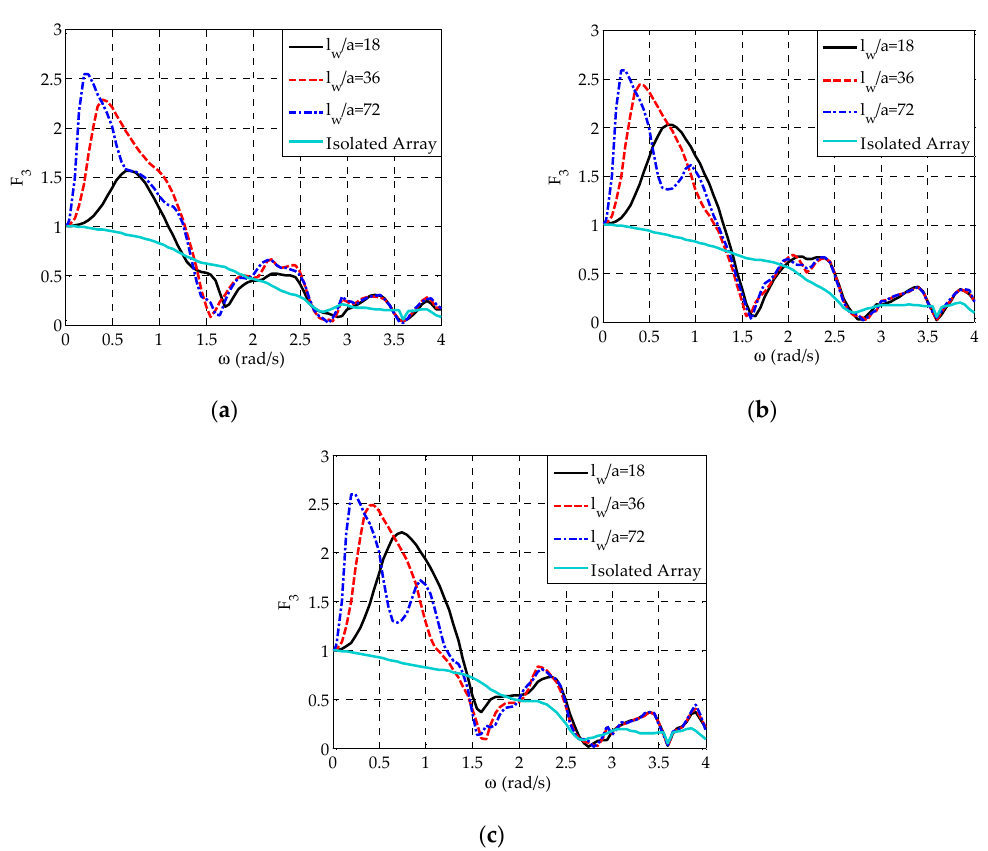
Figure 10. E ff ect of l w / a on F 3 applied on the semi-immersed oblate spheroidal WECs for c / a = 3 Figure 10. Effect of 𝑙 (cid:3050) /𝑎 on 𝐹 (cid:2871) applied on the semi-immersed oblate spheroidal WECs for 𝑐/𝑎 = 3 and 𝑙 (cid:3029)(cid:3032)(cid:3047) /𝑎 = 4 : ( a ) WEC1 and WEC5, ( b ) WEC2 and WEC4, and ( c ) WEC3.